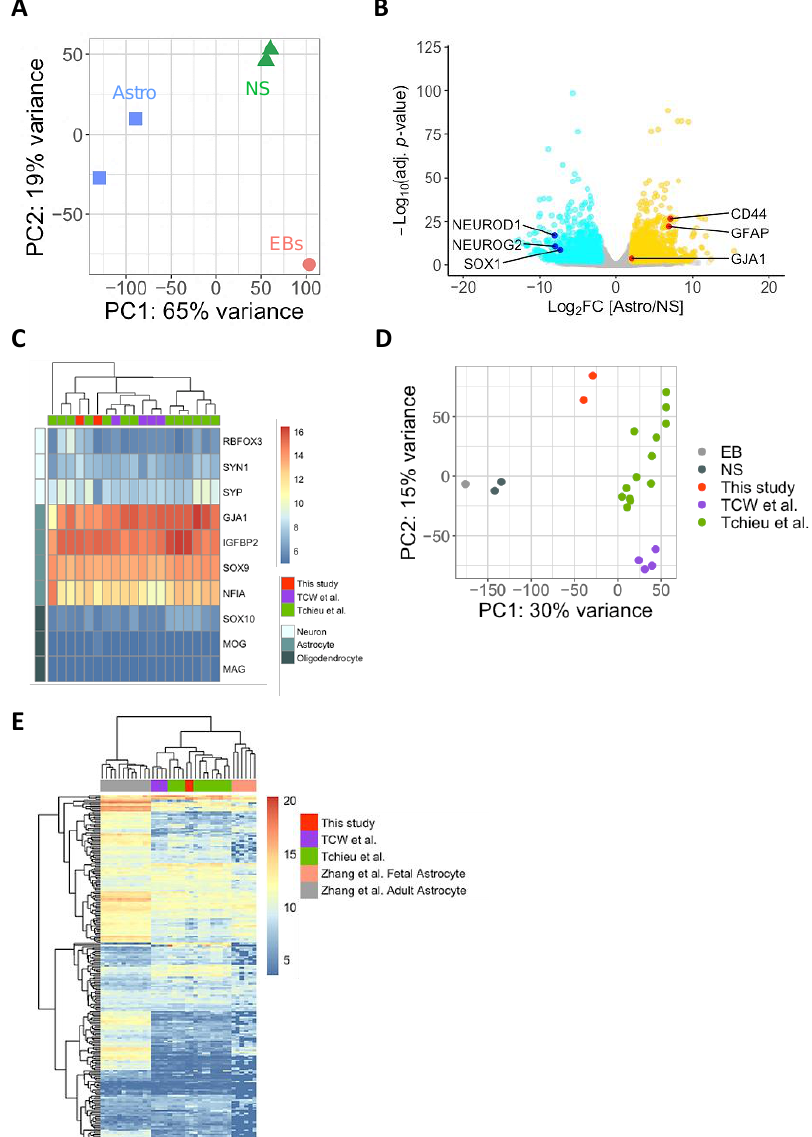
Figure 2. Transcriptome Analyses of iPasts. ( A ) Principal component analysis (PCA) plot of iPSC-derived cells differentiated along astrocyte lineage by the iPast protocol. ( B ) Volcano plot showing differential expressed genes between neurospheres (in blue) and astrocytes (in yellow). ( C ) Heatmap showing the expression of trilineage markers in iPSC-derived astrocytes obtained by the iPast protocol or previously described protocols. ( D ) PCA plot of iPSC-derived astrocytes, EBs and NS. ( E ) Heatmap of genes associated with astrocyte identity in iPSC-derived astrocytes and human primary